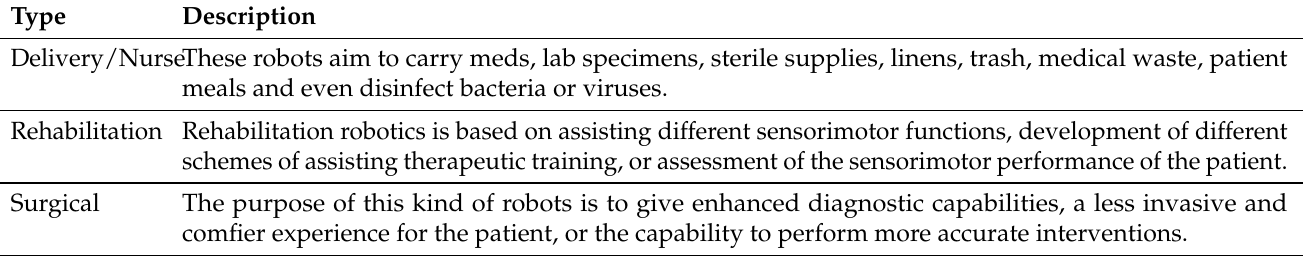
Table 2. Classification of medical robots according to the application